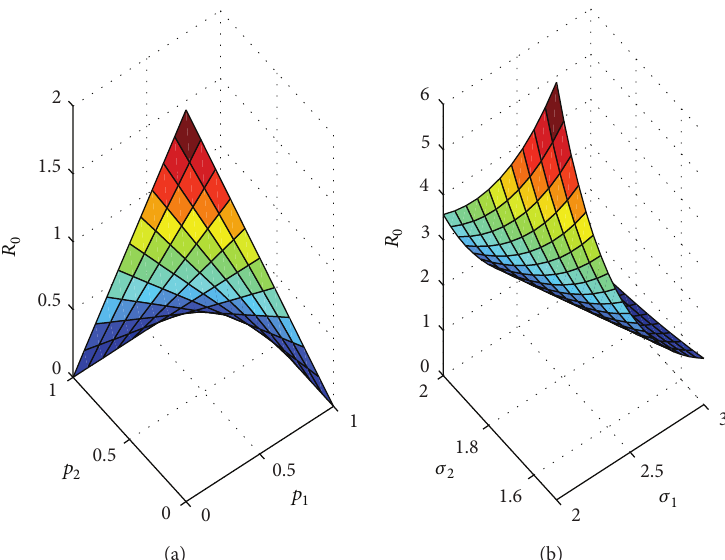
Figure5:Theeffectsofthepestkillingrates (𝑝 1 ,𝑝 2 ) andthereleasingquantities (𝜎 1 , 𝜎 2 ) onthethresholdcondition 𝑅 0 .Thebaselineparameter values are as follows: 𝑟(𝑡) = 2 + 0.3 cos (0.4𝜋𝑡) , 𝑏(𝑡) = 1 + 0.2 sin (0.4𝜋𝑡) , 𝛿(𝑡) = 0.5 + 0.1 cos (0.4𝜋𝑡) , 𝑇 = 5 , 𝜏 1 = 1 , 𝜏 2 = 3 . (a) The effect of the releasing quantities 𝑝 1 and 𝑝 2 on 𝑅 0 with 𝜎 1 = 2.5 and 𝜎 2 = 1.8 ; (b) the effect of pest killing rates 𝜎 1 and 𝜎 2 on 𝑅 0 with 𝑝 1 = 0.25 and 𝑝 2 = 0.2